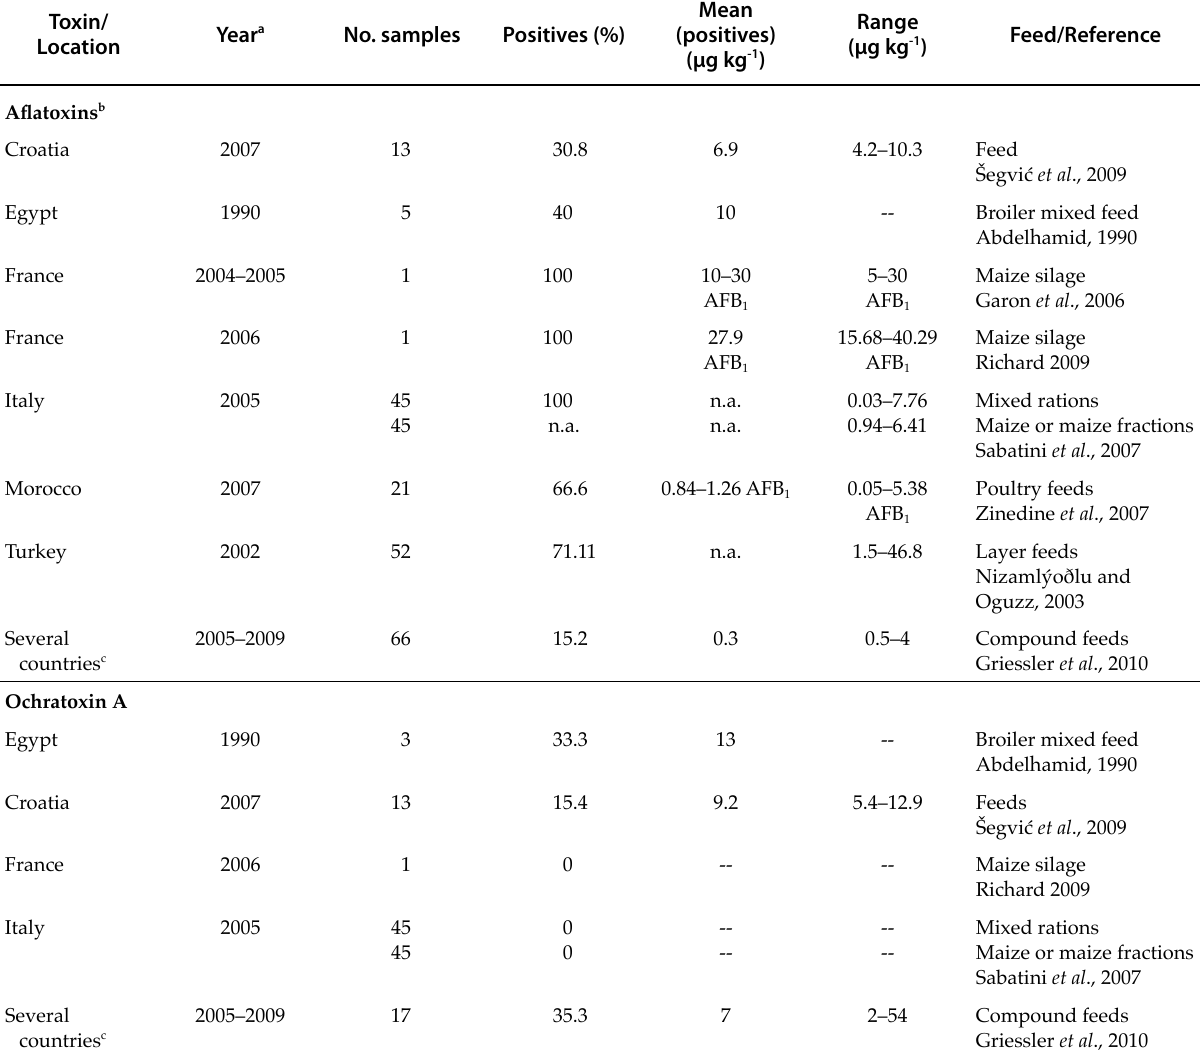
Table 7. Occurrence of aflatoxins and ochratoxin A in maize-based feeds from Mediterranean countries. Toxin/